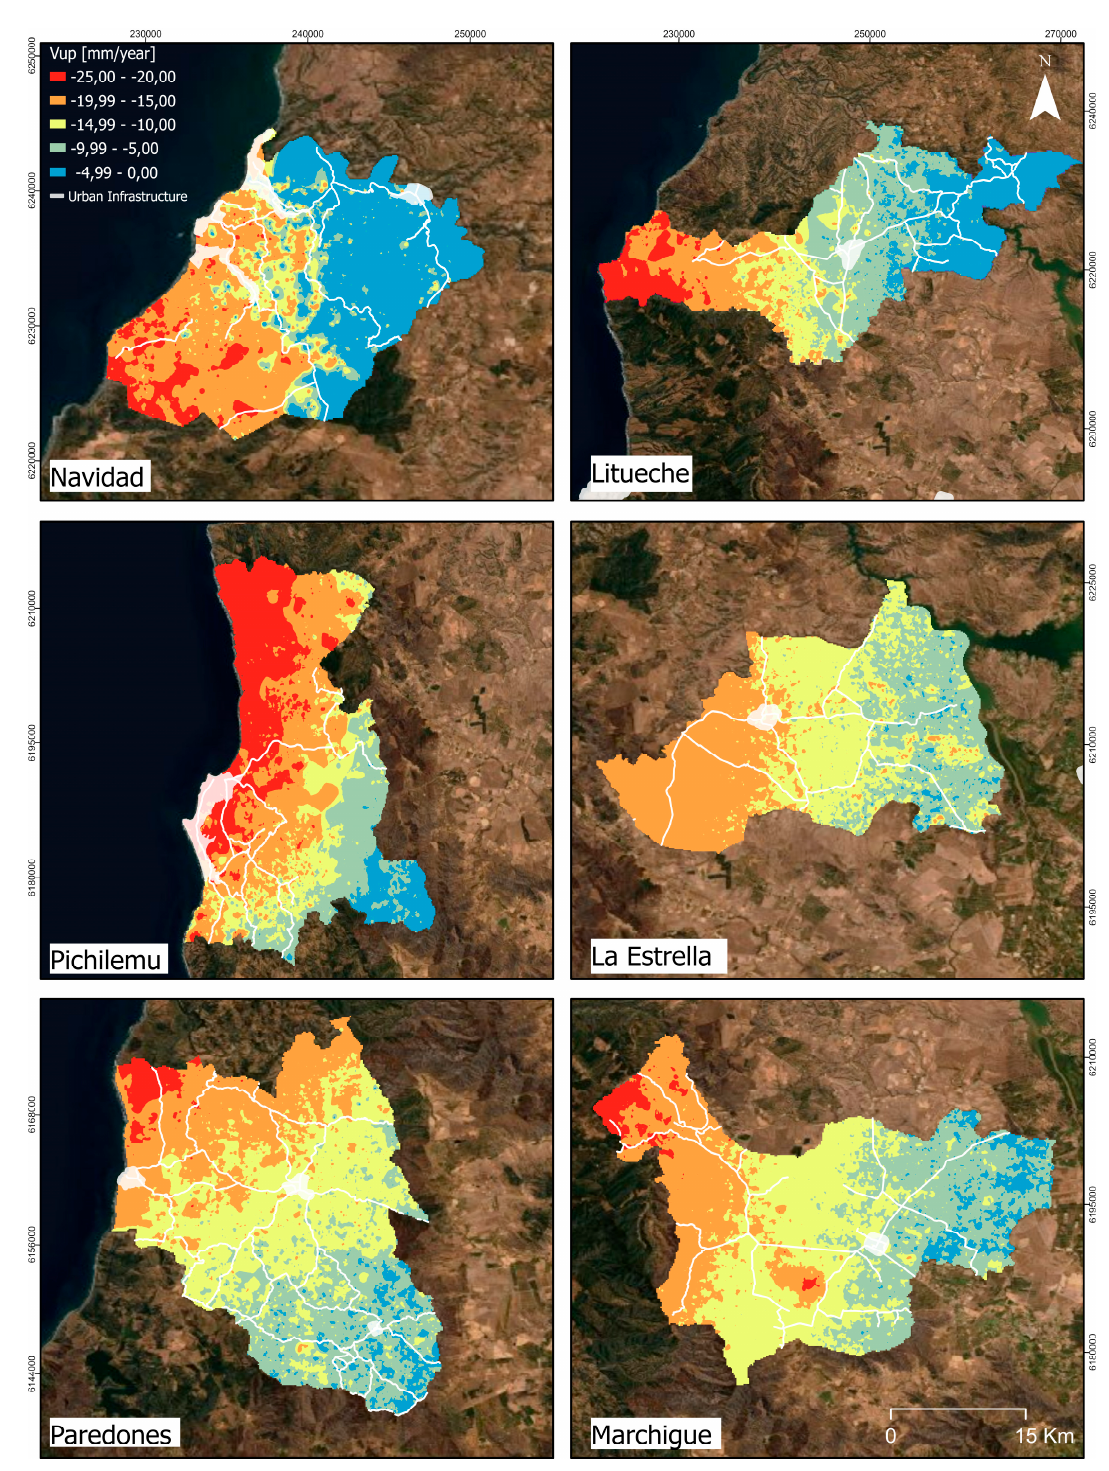
Figure 10. Vertical displacement, Vup maps (mm/year), for each of the municipalities in the subsidence area (Navidad, Pichilemu, Paredones, Litueche, La Estrella, and Marchigue).